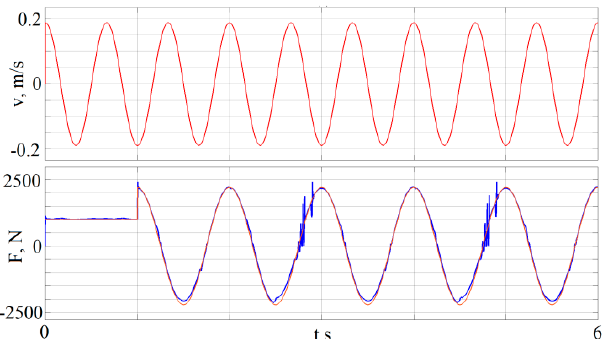
Figure 11. Desired force as a sine wave with increasing frequency. Top: velocity of the rod; bottom: force on the rod (red—desired, blue—actual).